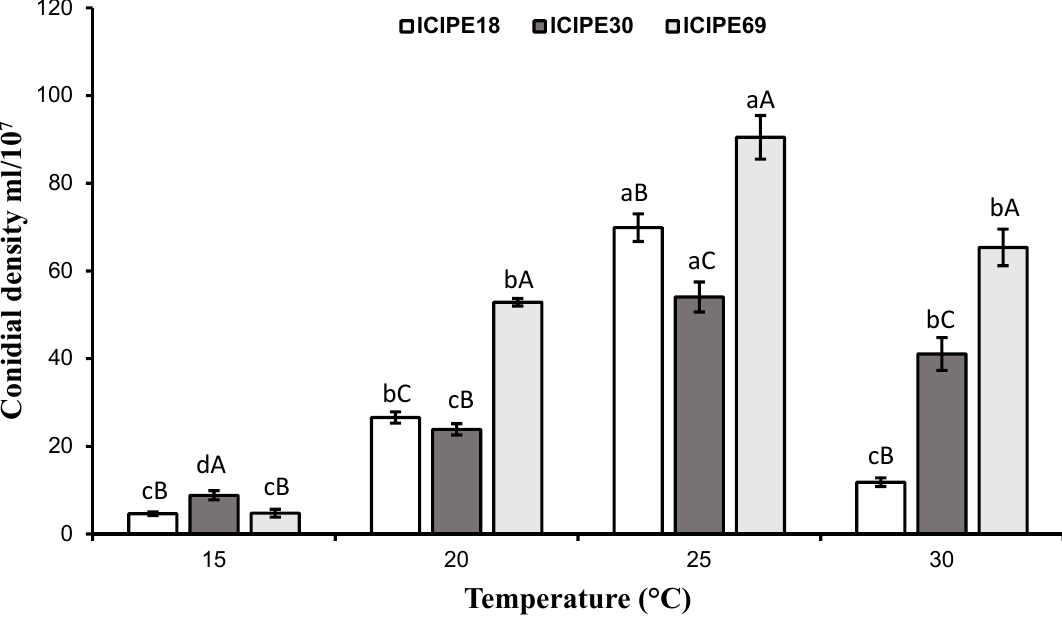
Figure 2. Effect of temperature on conidia production/sporulation of the three Metarhizium anisopliae isolates. Means with the same lowercase letter are not significantly different under same temperature among different isolates while those with the same upper case letter are not significantly different under same isolate across different temperature based on Tukey’s HSD multiple range test at p = 0. 05.